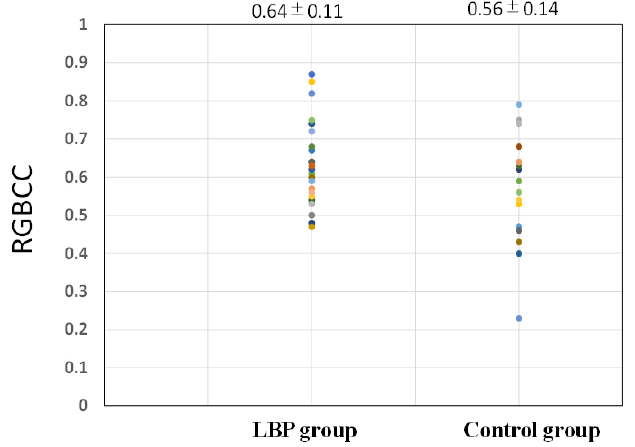
Figure 5. Comparison of red, green, and blue correlation coefficient between the lower back pain group and the control group.